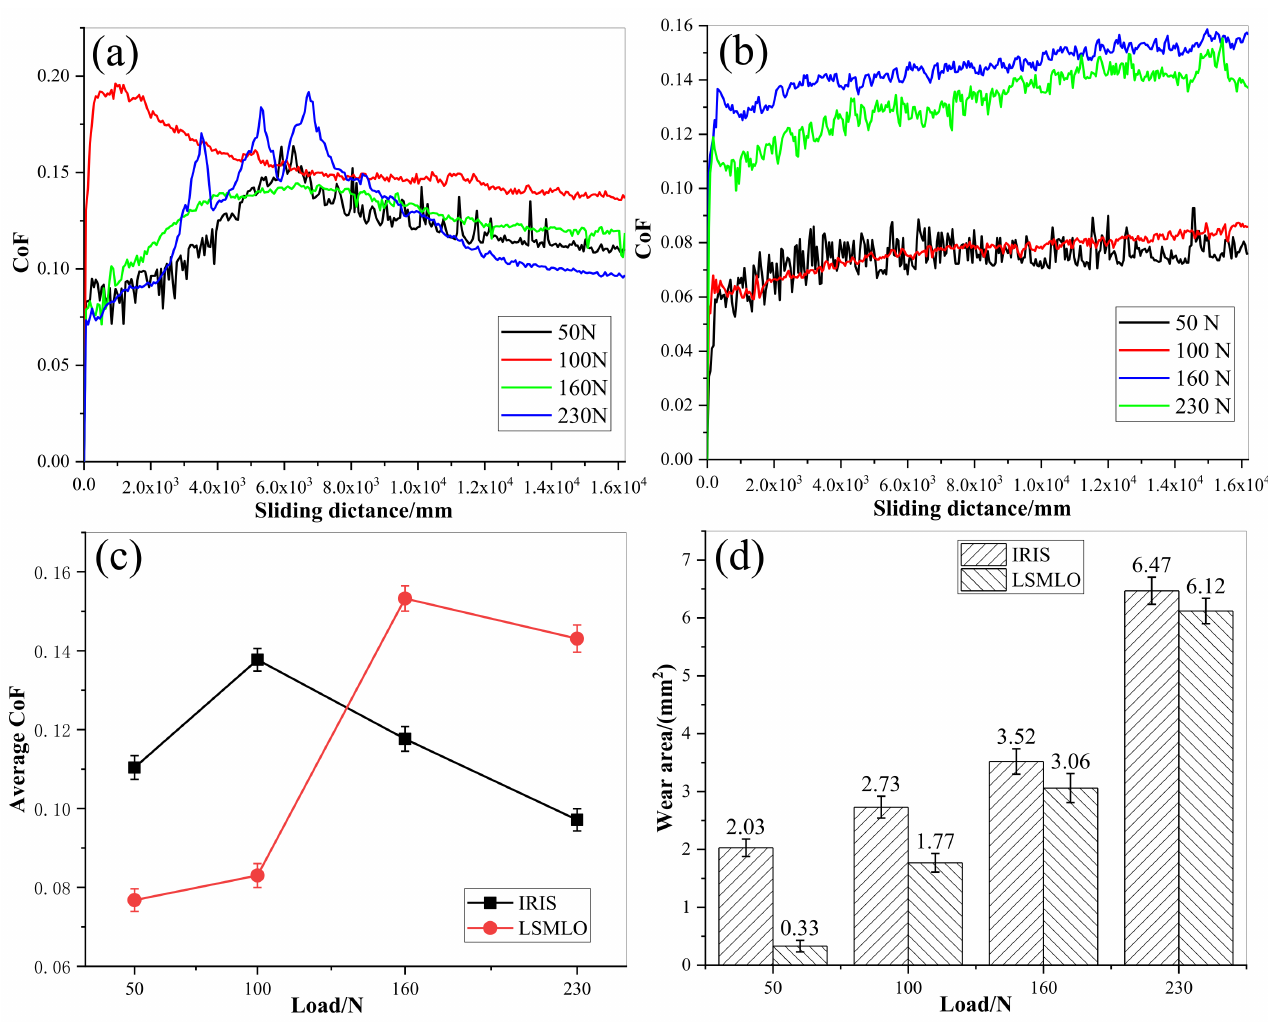
Figure 14. CoFs and wear areas of wire ropes under different contact loads lubricated with IRIS and LSMLO. ( a ) evolutions of CoF under IRIS lubrication; ( b ) evolutions of CoF under LSMLO lubrication; ( c ) comparison of average CoF between IRIS and LSMLO lubrication; ( d ) evolutions of wear area under IRIS and LSMLO